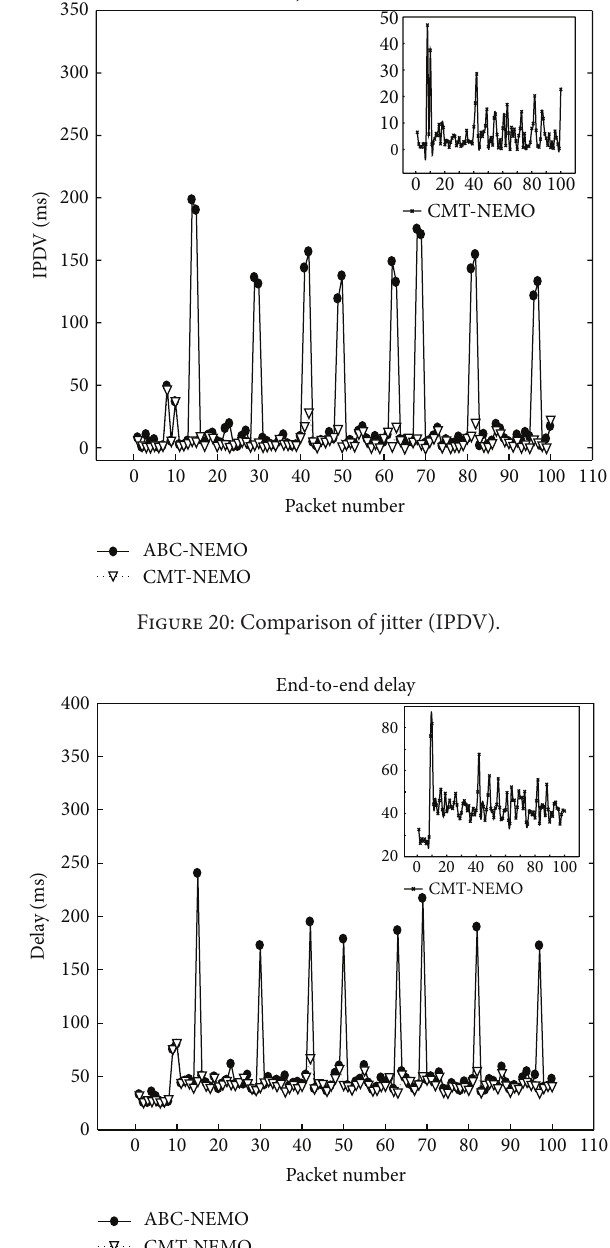
Figure 19: Comparison of jitter (running IPDV).